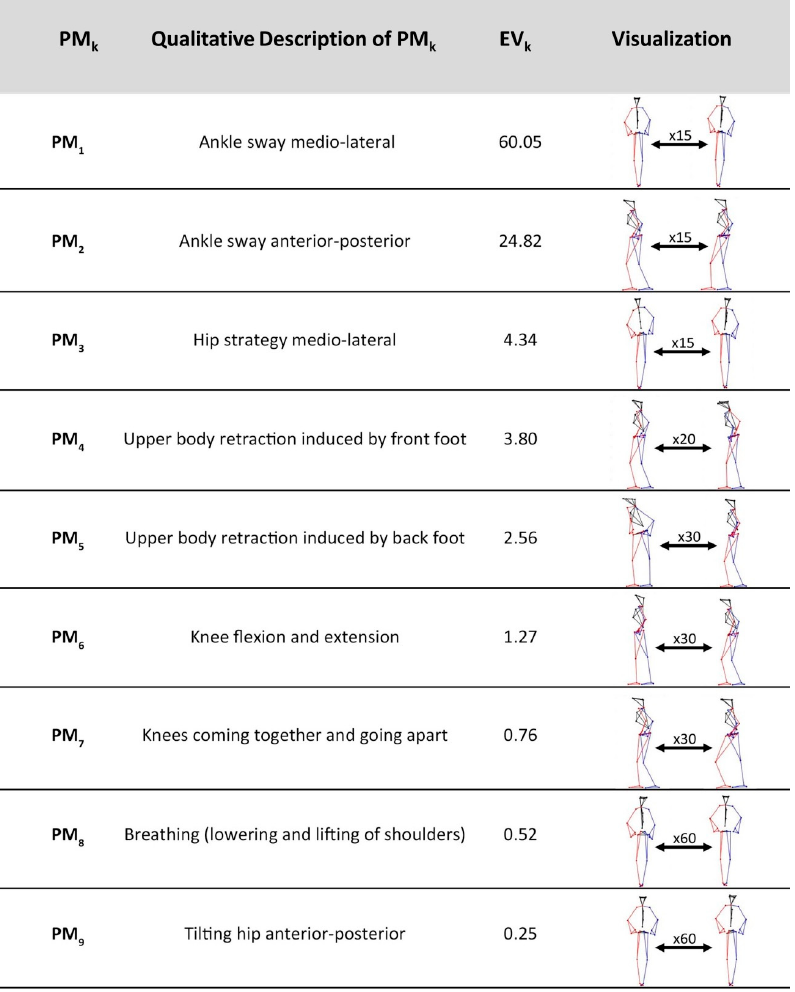
Figure 1. Qualitative description of the first nine movement components ( PM k ). The Eigenvalues EV k indicate the contribution of each PM k to the overall movement; the visualization of the components was amplified by factor x .